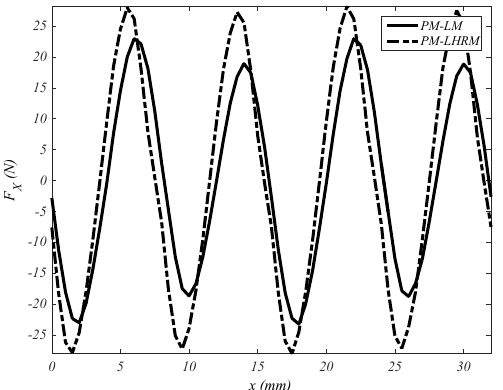
Figure 4. Detent force or cogging force for PM-LM and PM-LHRM at shift = 0 mm.